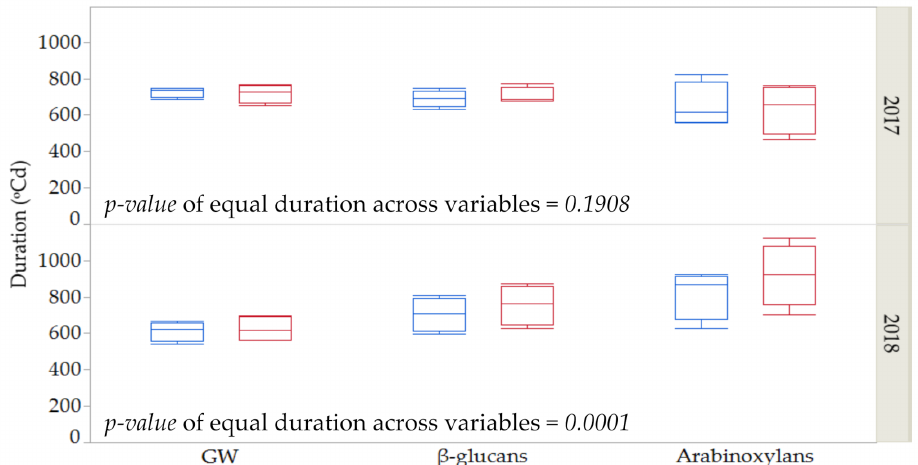
Figure 2. Estimates and standard error for duration for grain weight (GW), β -glucan and arabinoxy- lan contents across years (2017 and 2018) under control ( blue ) and stressed conditions ( red ) among four